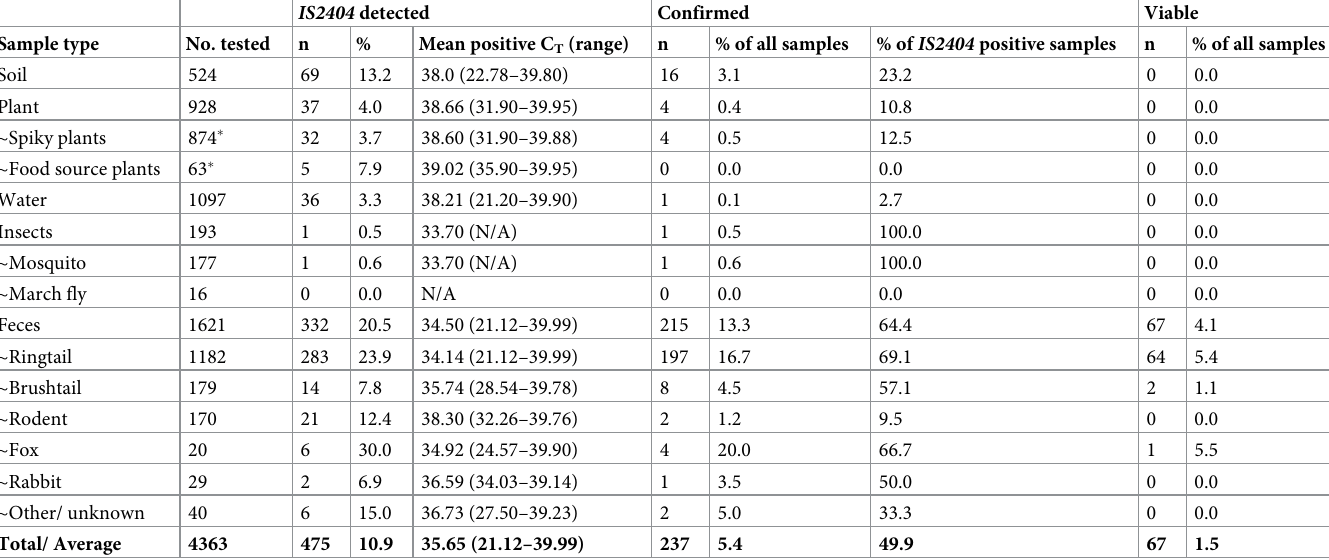
Table 1. Results of sample testing by sample type, with sub-type shown for fecal and insect